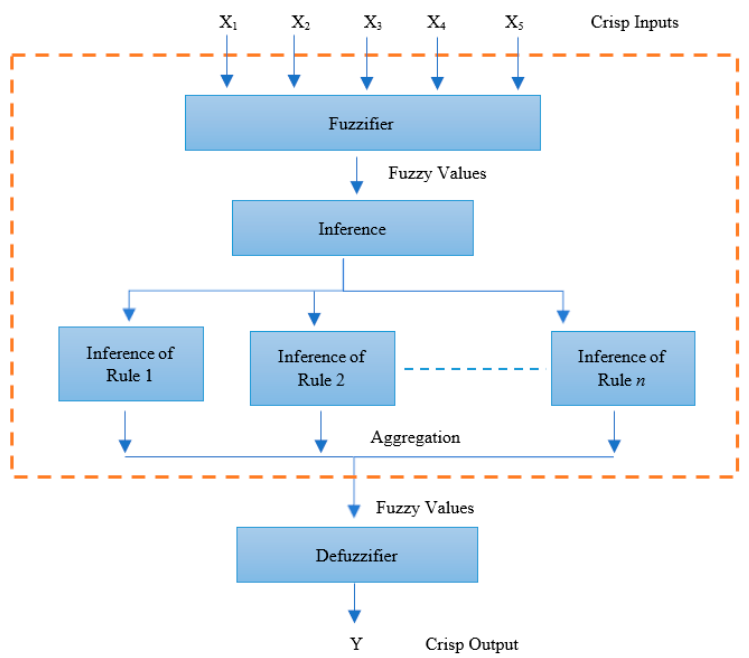
Figure 4. The fuzzy logic system for the smart irrigation system.